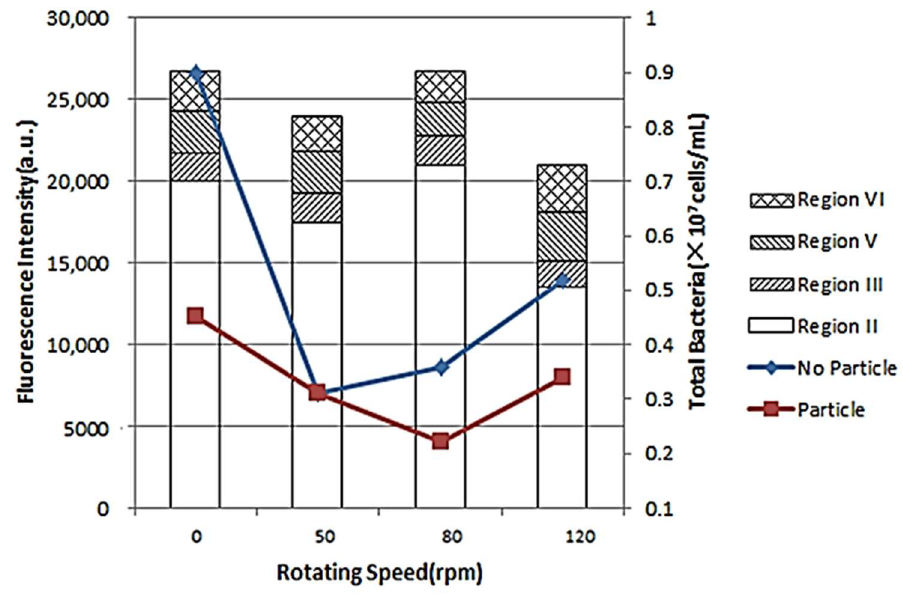
Figure 5. Impact of rotating speed on microbial biofilm formation and the fluorescence intensity of EPS.